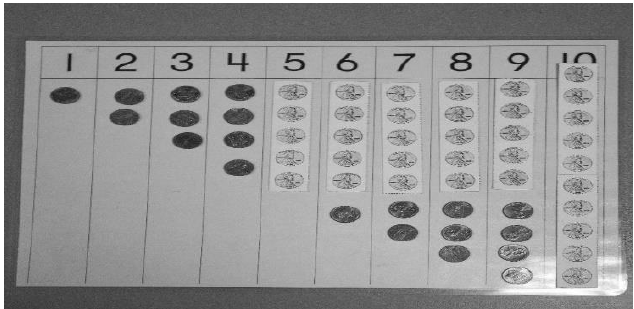
Figure 1 . Intervention and the intervention specific task. One through ten board from Math Expressions. The instructions were: "You have a board, pennies and nickel strips. You are going to make the numbers one through ten on your boards using pennies and nickel strips. You can use pennies to make all of the numbers. You